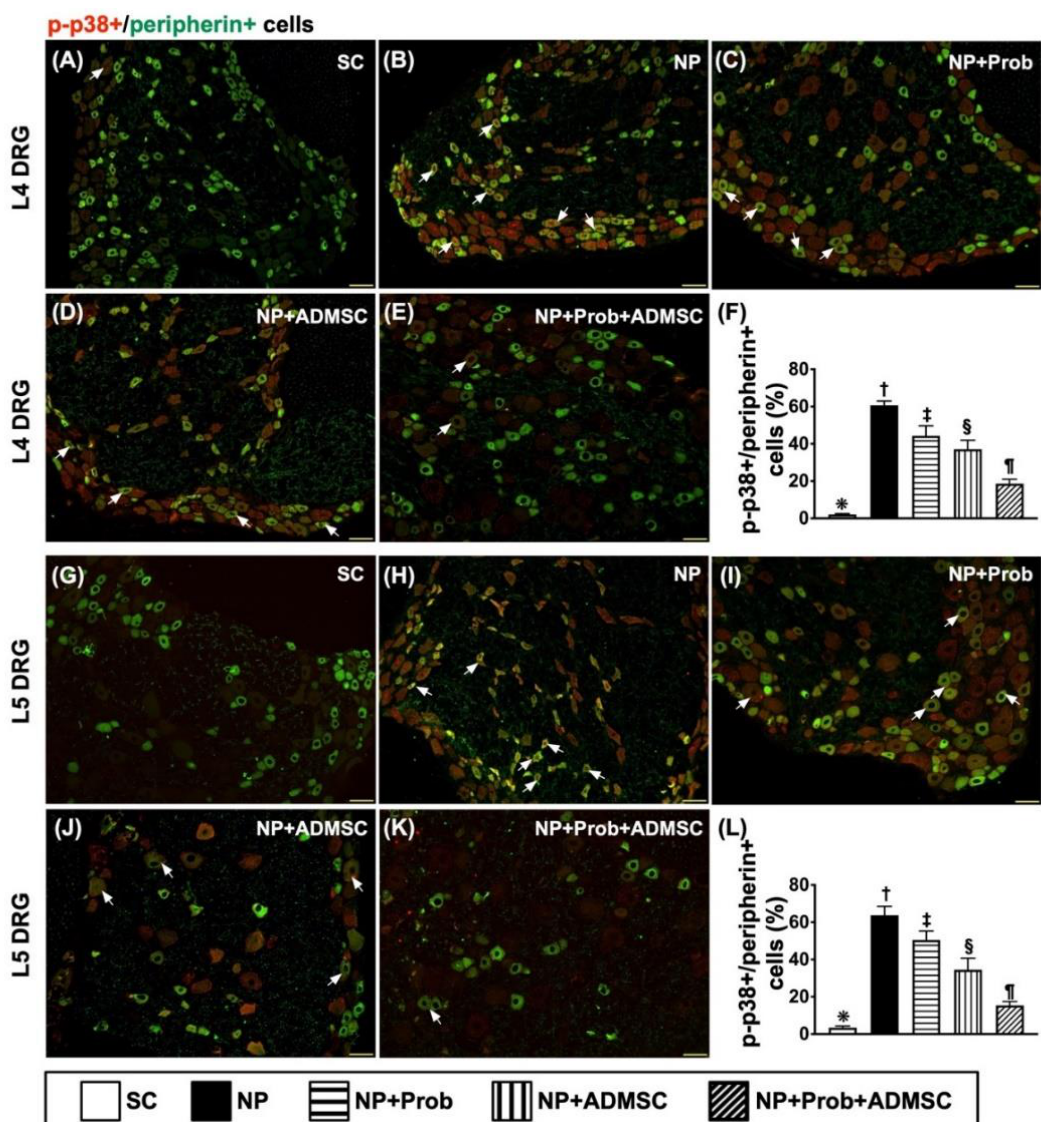
Figure 6. Cellular expression of co-localizations between p-p38 and peripherin in L4-L5 DRGs by day 60 after NP induction L4 DRG level: ( A – E ) Showing the immunofluorescent (IF) microscopic findings (200 × ) to identify merged positively stained p-P38 and peripherin (green–red co-localization). ( F ) Analytical results of number of p-P38+/peripherin+ cells, * vs. other groups with different symbols (†, ‡, §, ¶), p < 0.0001. L5 DRG level: ( G – K ) Showing IF microscopic finding (200 × ) for identifying merged positively-stained p-P38 and peripherin (green-red co-localization). ( L ) Analytical results of number of p-P38+/peripherin+ cells, * vs. other groups with different symbols (†, ‡, §, ¶), p < 0.0001. Note that the white arrows indicate the merged double stain of p-P38+/peripherin+. Scale bars in the lower-right corner represent 50 µ m. Symbols (*, †, ‡, §, ¶) indicate significance for each other (at 0.05 level). All statistical analyses were performed using one-way ANOVA followed by Bonferroni multiple comparison post hoc test (n = 8 for each group). SC = sham control; NP = neuropathic pain; Prob = probiotics; ADMSCs = adipose-tissue derived mesenchymal stem cells.